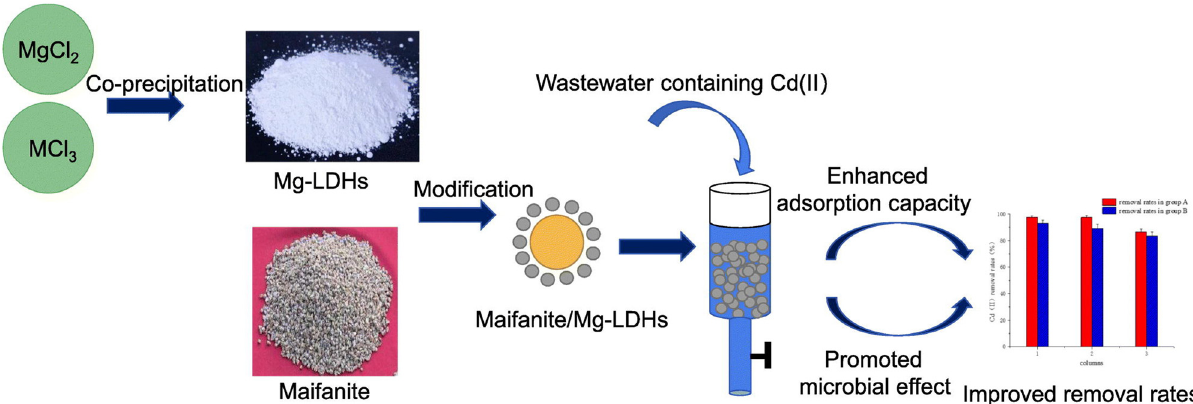
Figure 10: Schematic diagram of the preparation of Maifanite/Mg - LDHs and its application in CRIS [ 139 ]